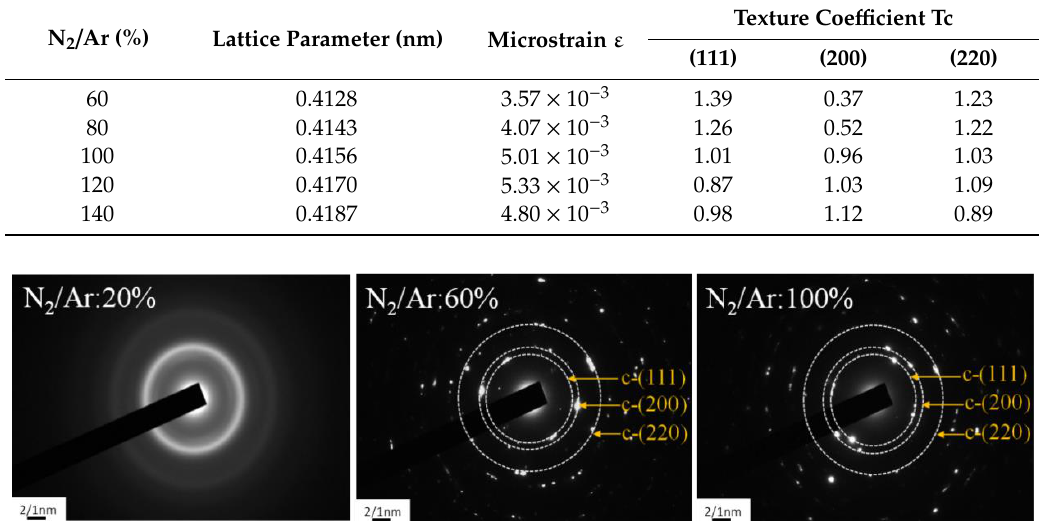
Figure 2. Selected area electron diffraction (SAED) patterns of CrAlN layers formed under N 2 /Ar flow ratios of 20%, 60%, and 100%. Table 2. Lattice parameters and texture coefficient of CrAlN layer under various N 2 /Ar flow ratios.